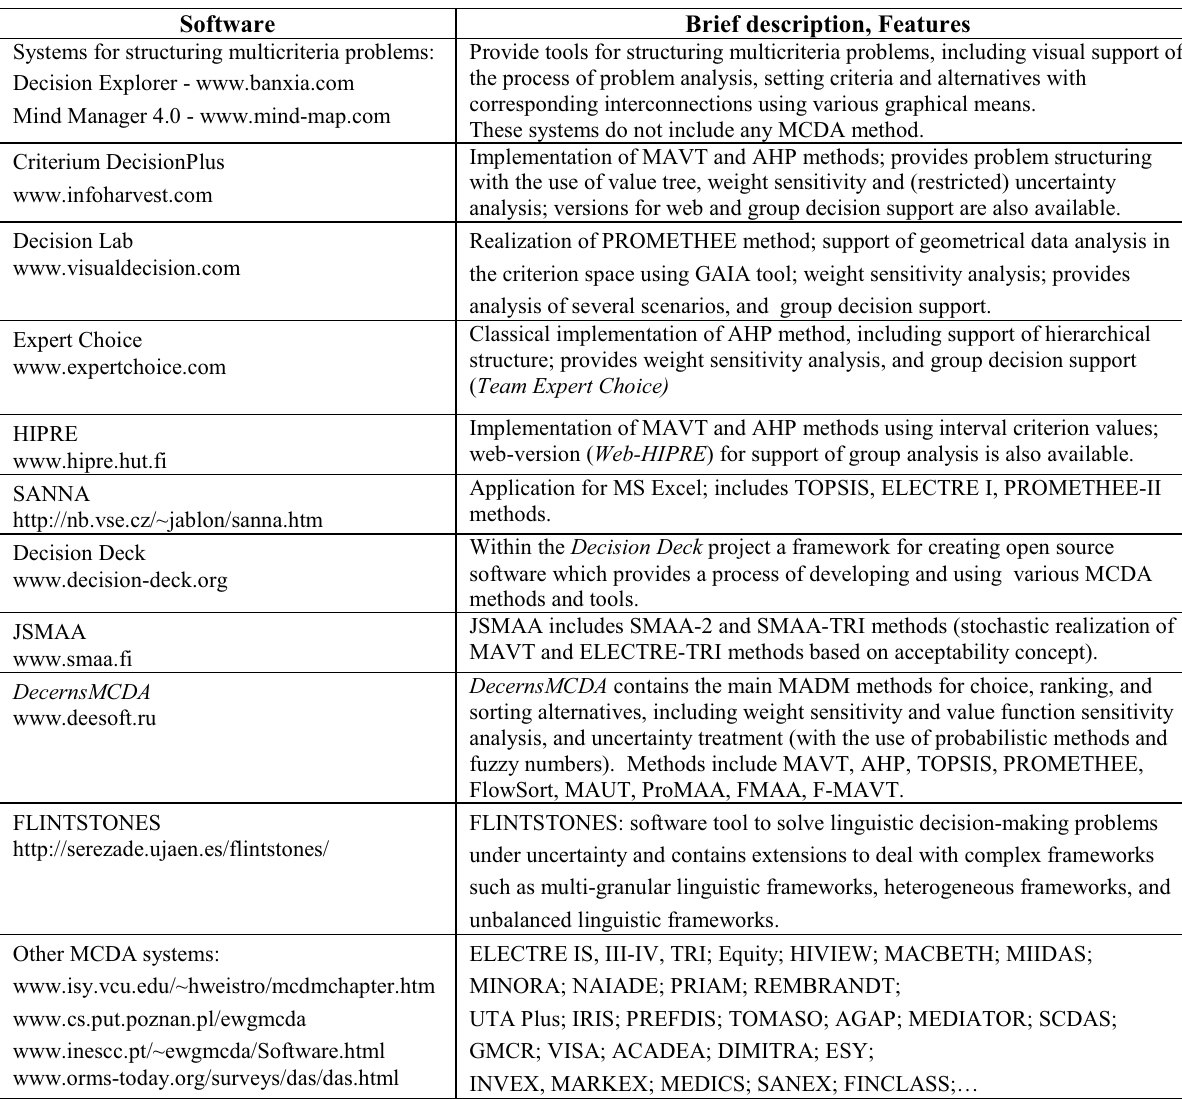
Table 1. Computer systems for decision analysis (with implementation of MADM